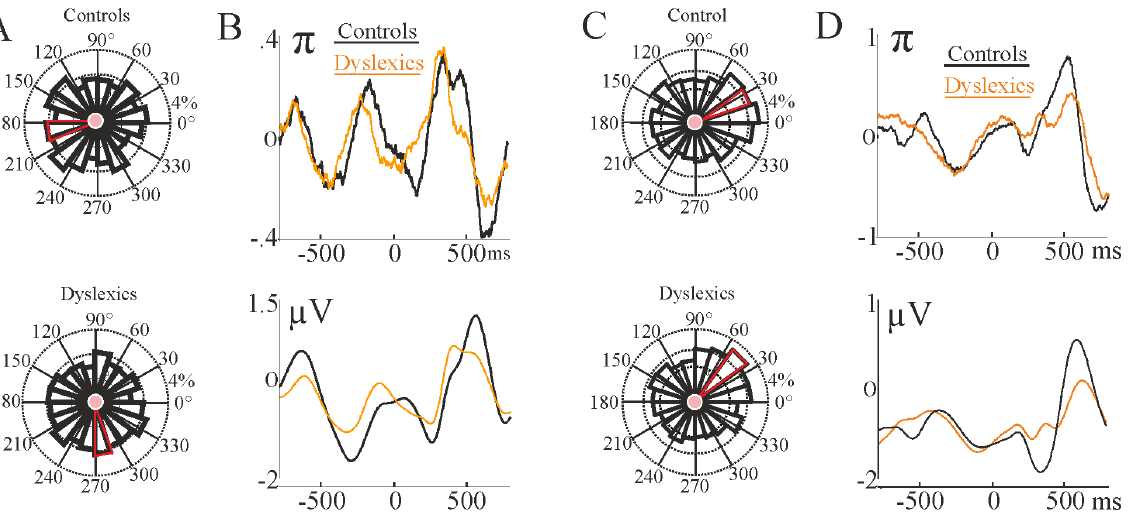
Figure 4. Phase entrainment of prestimulus delta oscillation by group. Panel A: Phase distribution in the 2 Hz condition is plotted as a rose diagram (from the electrode approximately corresponding to FCz in the 10–20 electrode location system, see figure 1), with the radial extent of the petals representing the probability of a given phase range. Top row depicts controls, bottom row depicts dyslexics. The red petal indicates the mean angle for each group. Panel B: Upper: Phase angle (depicted via p ) of the delta oscillation along the whole epoch (from 2 800 to 800 ms) for both groups. Lower: Average EEG trace showing the delta oscillation along the whole epoch (from 2 800 to 800 ms) illustrating the ongoing nature of the delta oscillation for both groups. Panel C and D show analogous plots to Panel A and B, but for the 1.5 Hz condition.